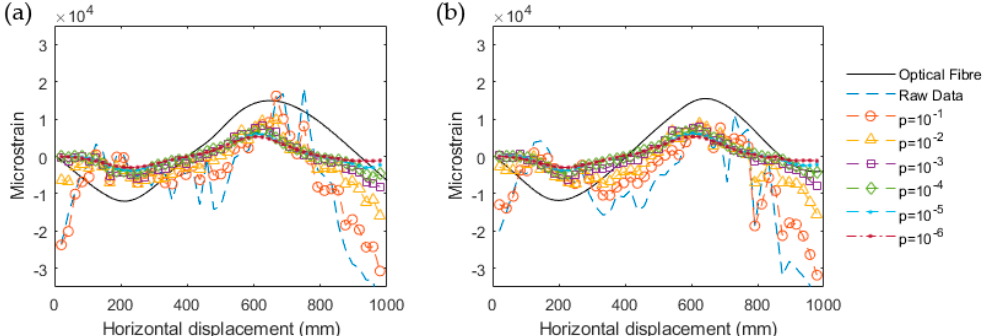
Figure 16. In-plane deformation test Step 1 strain ( a ) at 180 mm and ( b ) 320 mm of optical fibre and different cubic smoothing spline weighting parameter from 10 − 1 to 10 − 6 .